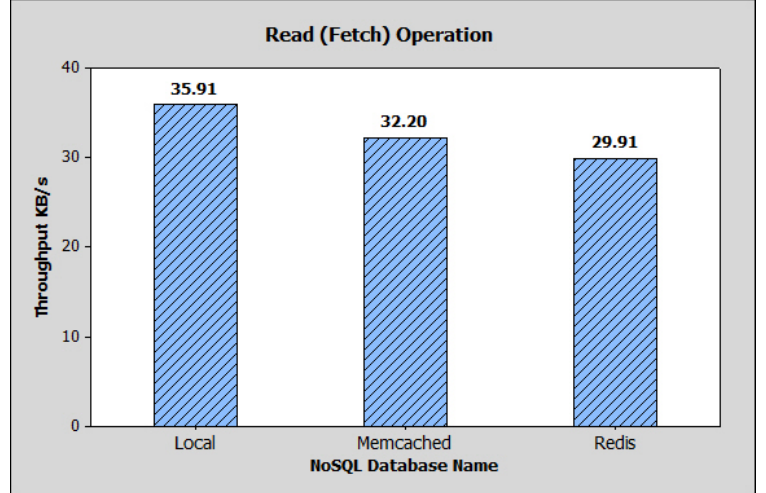
Figure 4. Throughput with read operation (Single Client).